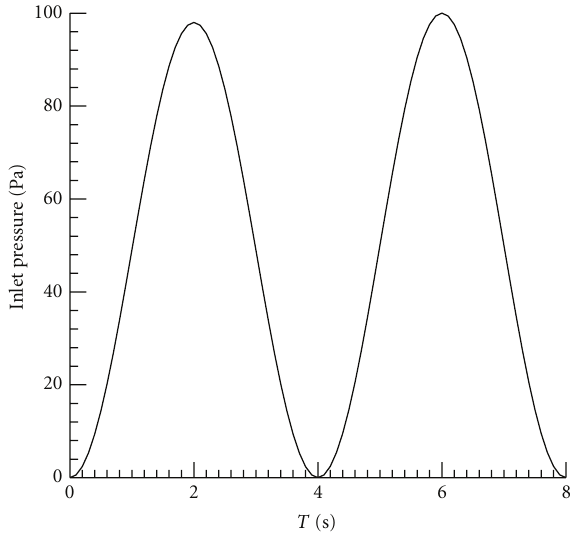
Figure 5: Prescribed inlet